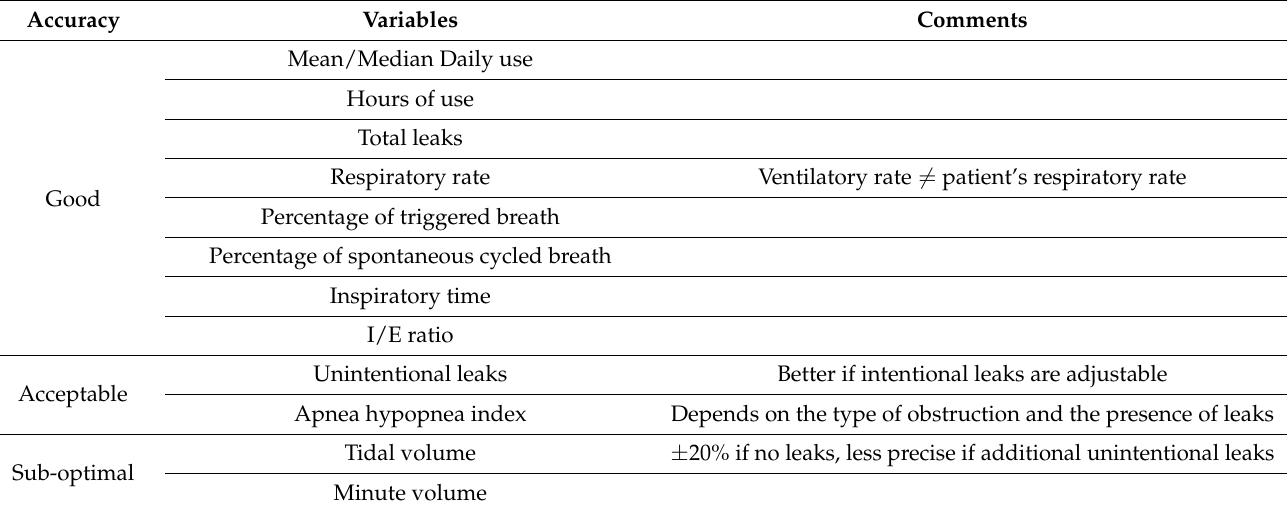
Table 1. Accuracy of the variables recorded by the ventilators to be used as clinical